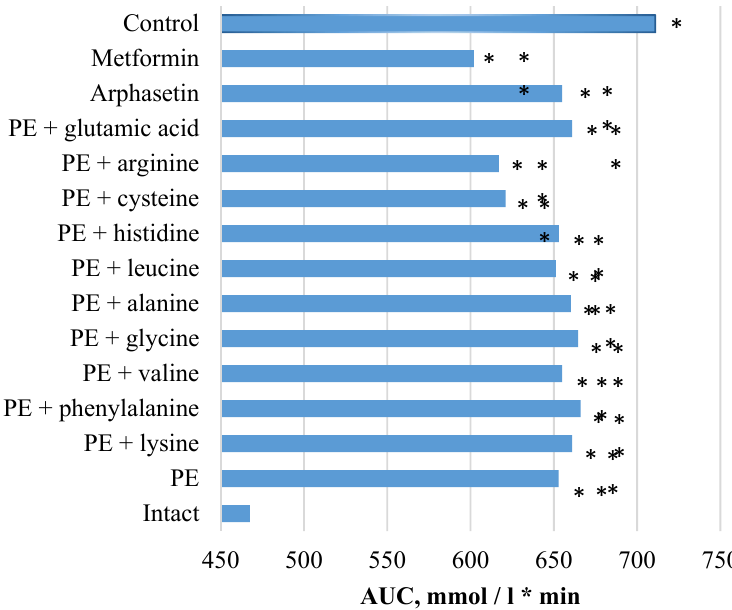
Fig. 3. Calculation of the area under the curve (AUC) when conducting OGTT with the administration of dry extracts of bearberry ordinary leaves: * – p ≤ 0.05 compared to intact; ** – p ≤ 0.05 compared to